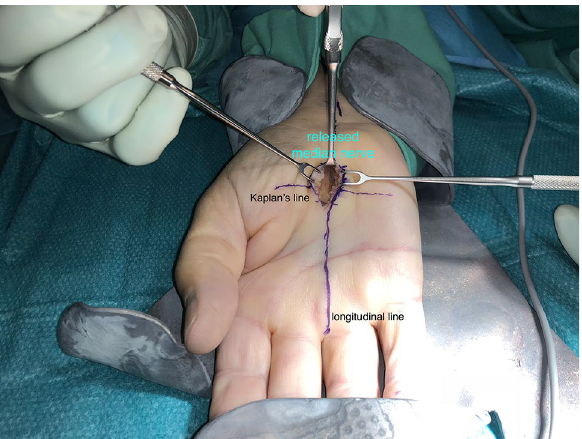
Figure 6. Intraoperative picture of the MCTR: Release of the transverse carpal ligament is achieved. The median nerve can be visualized ensuring its complete release. The final examination for further perineural scar tissue can be applied without any problems. {MEDICON eG, Art.-No. 20.50.05, Art.-No. 20.12.20, Germany}. MCTR mini-open carpal tunnel release, OCTR Open carpal tunnel release.